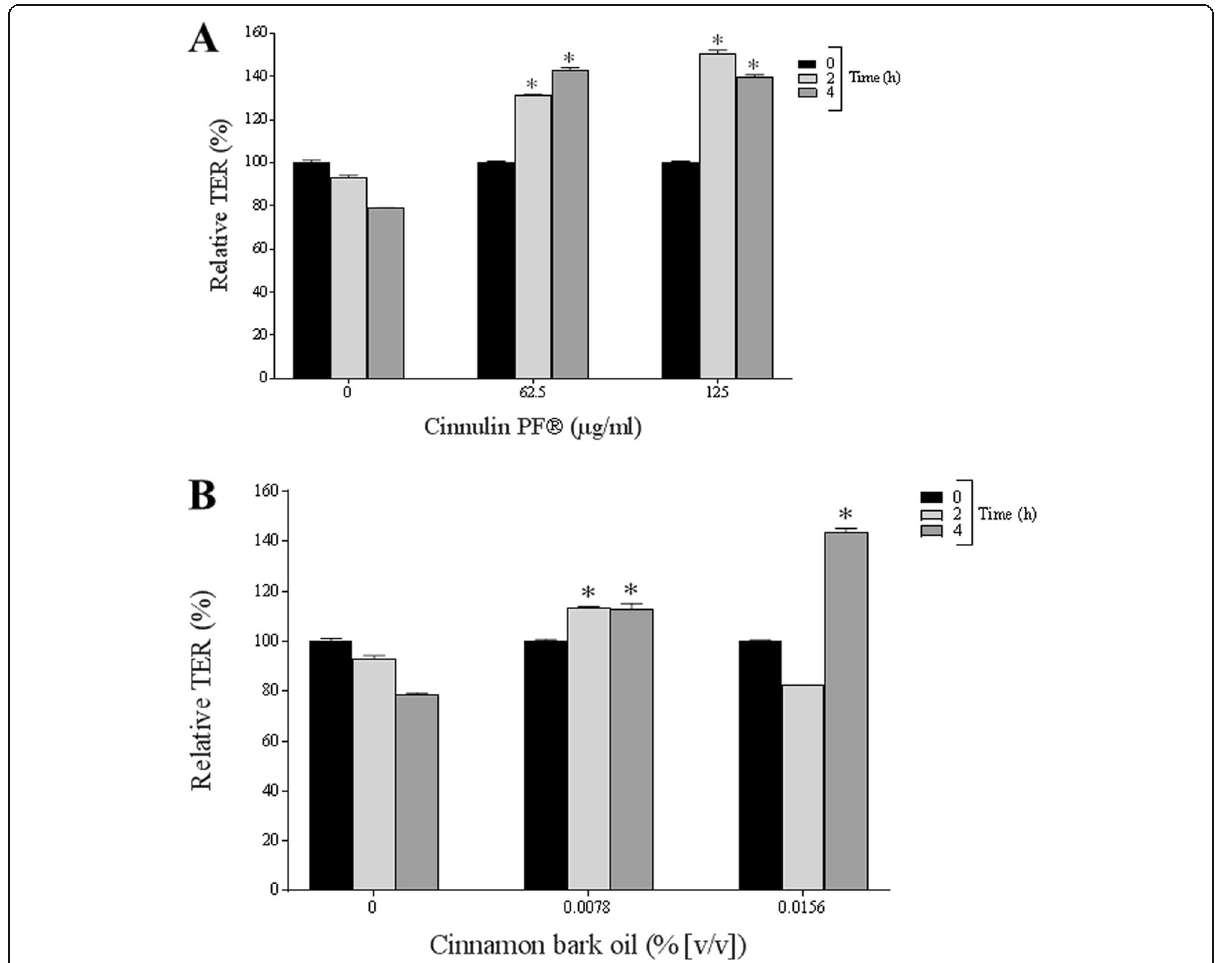
Fig. 7 Effect of Cinnulin PF® (panel a ) and cinnamon bark oil (panel b ) on the integrity of the epithelial barrier (B11 cell line). The TER values were determined after a 6-h incubation. A value of 100% was assigned to the TER values at time 0. Results are expressed as the means ± SD of triplicate assays. *: significantly different from the control ( p <